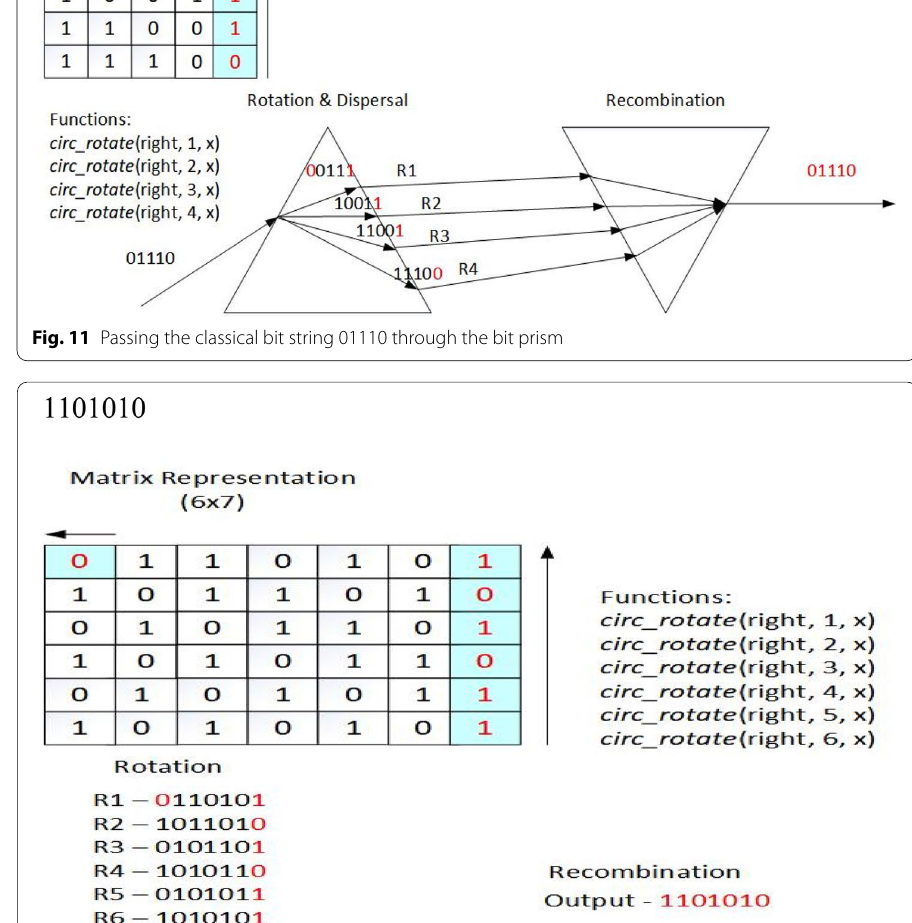
Fig. 12 Passing the classical bit string 1101010 through the bit